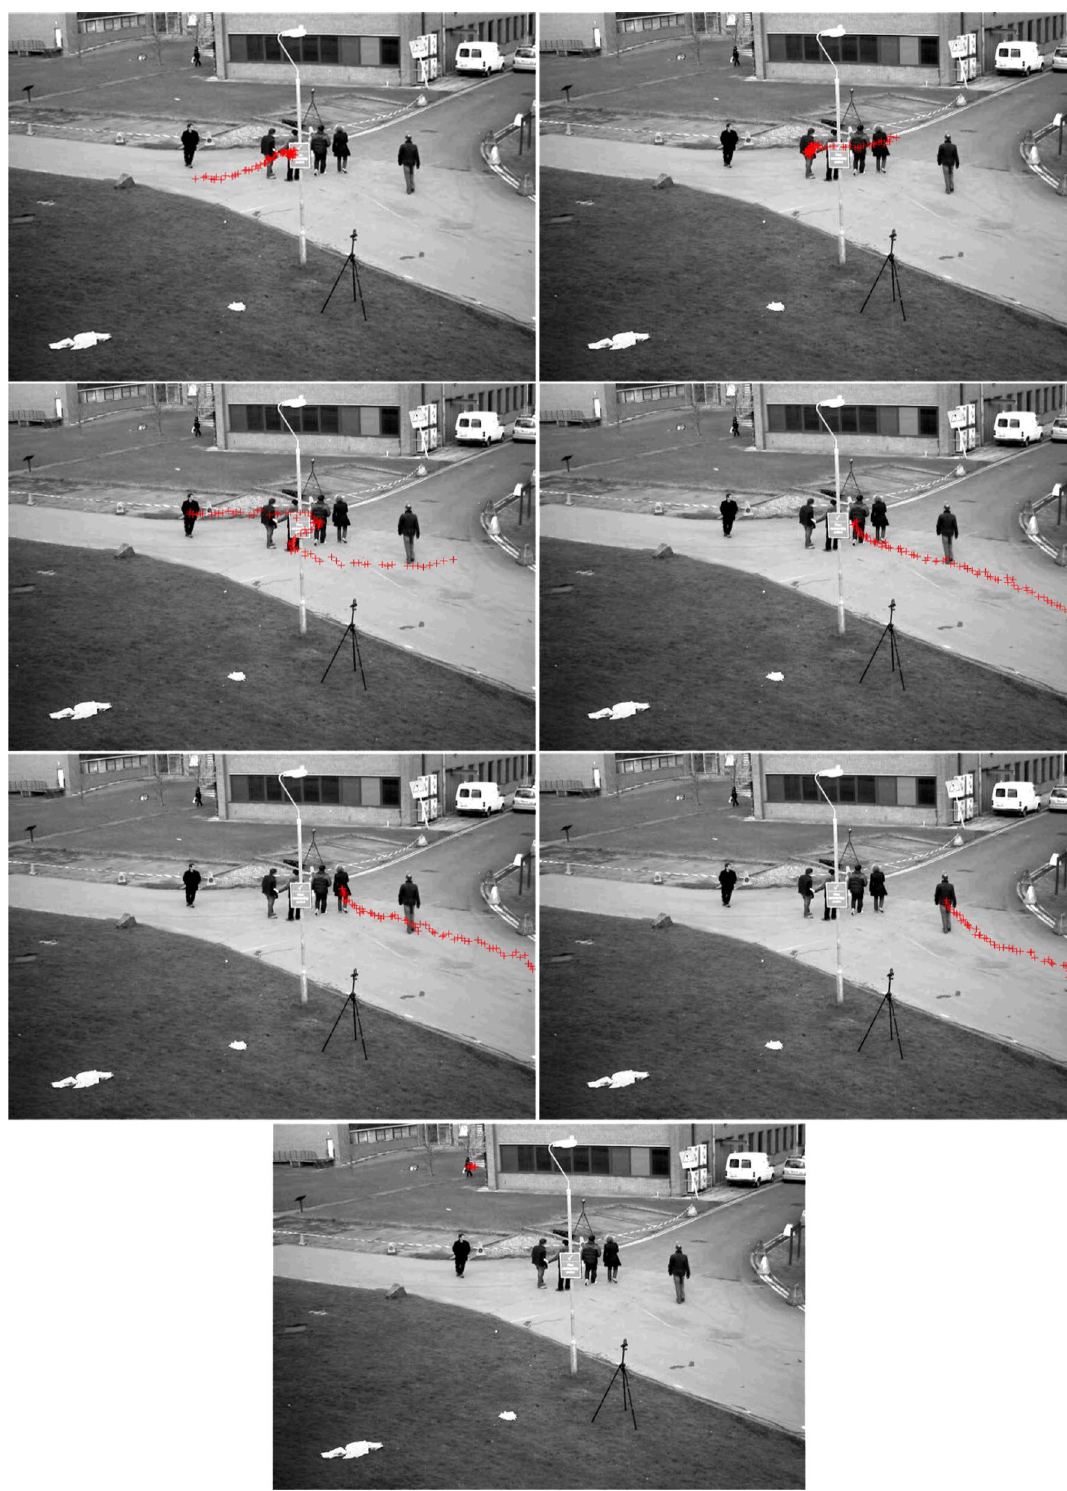
Fig. 7 Tracking of targets numbered 1 to 7 (Table 5) up to the frame numbered 80 by the proposed